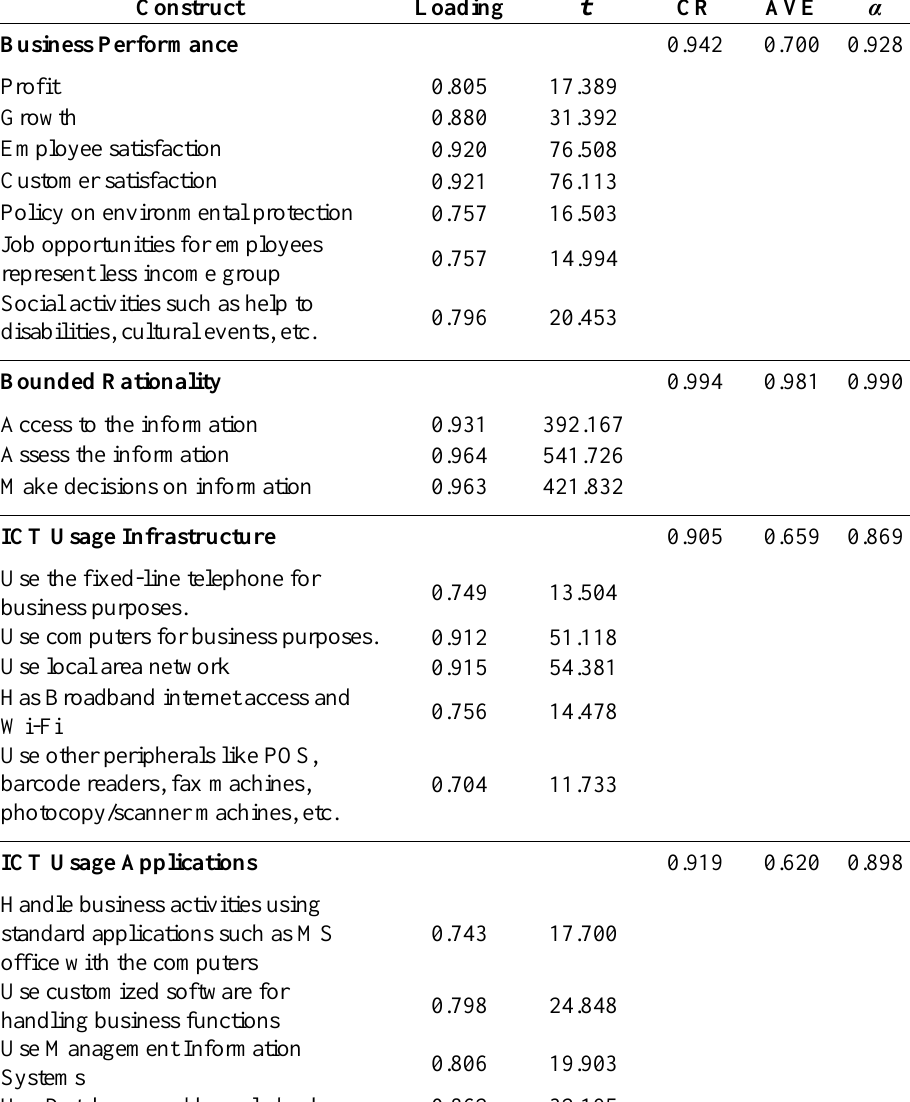
Table 3: Analysis of Second-Order